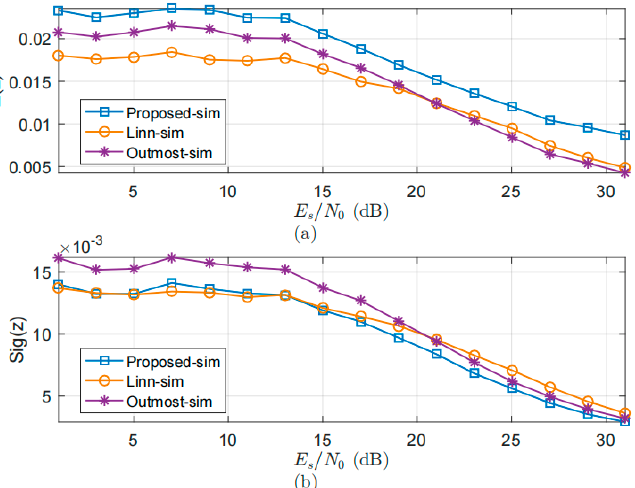
Figure 5. Expectation and variance versus SNR under the condition that carrier synchronization is unlocked for the 16APSK signal: ( a ) expectation; ( b ) variance.